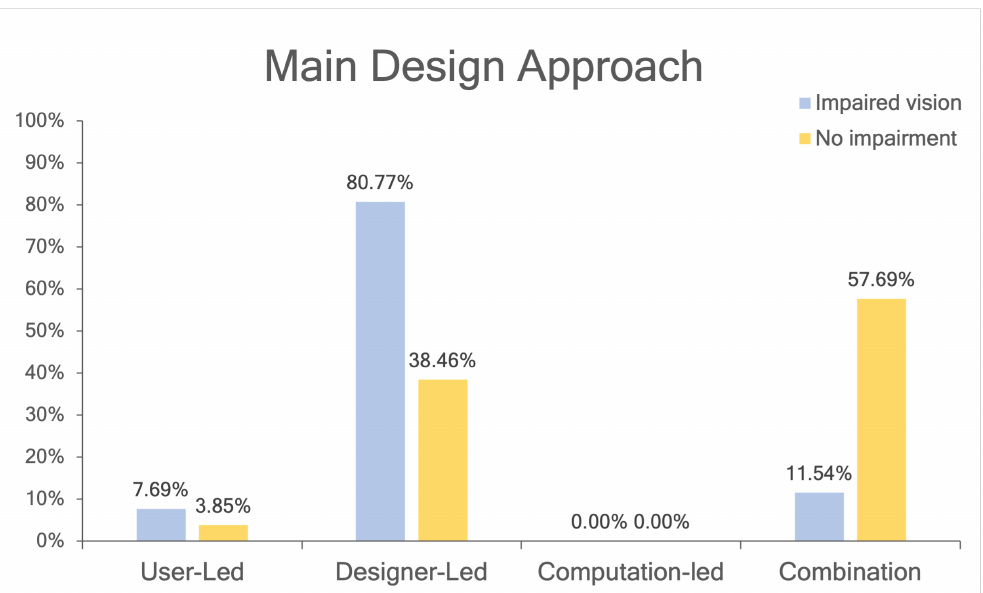
Figure 4. Design approaches for prototypes aimed at VIBPs and non-impaired persons.